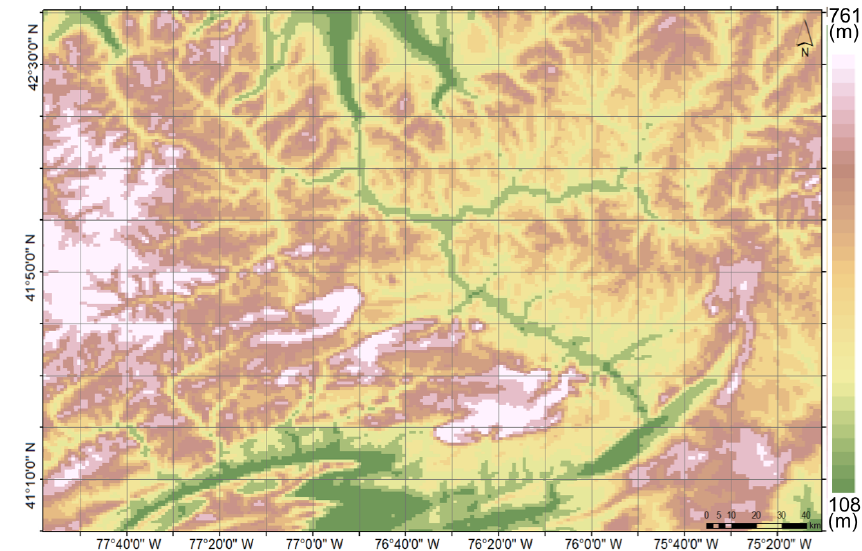
Figure 17. Domain 3 topography map. The elevation ranges from 108 to 761m above sea level.